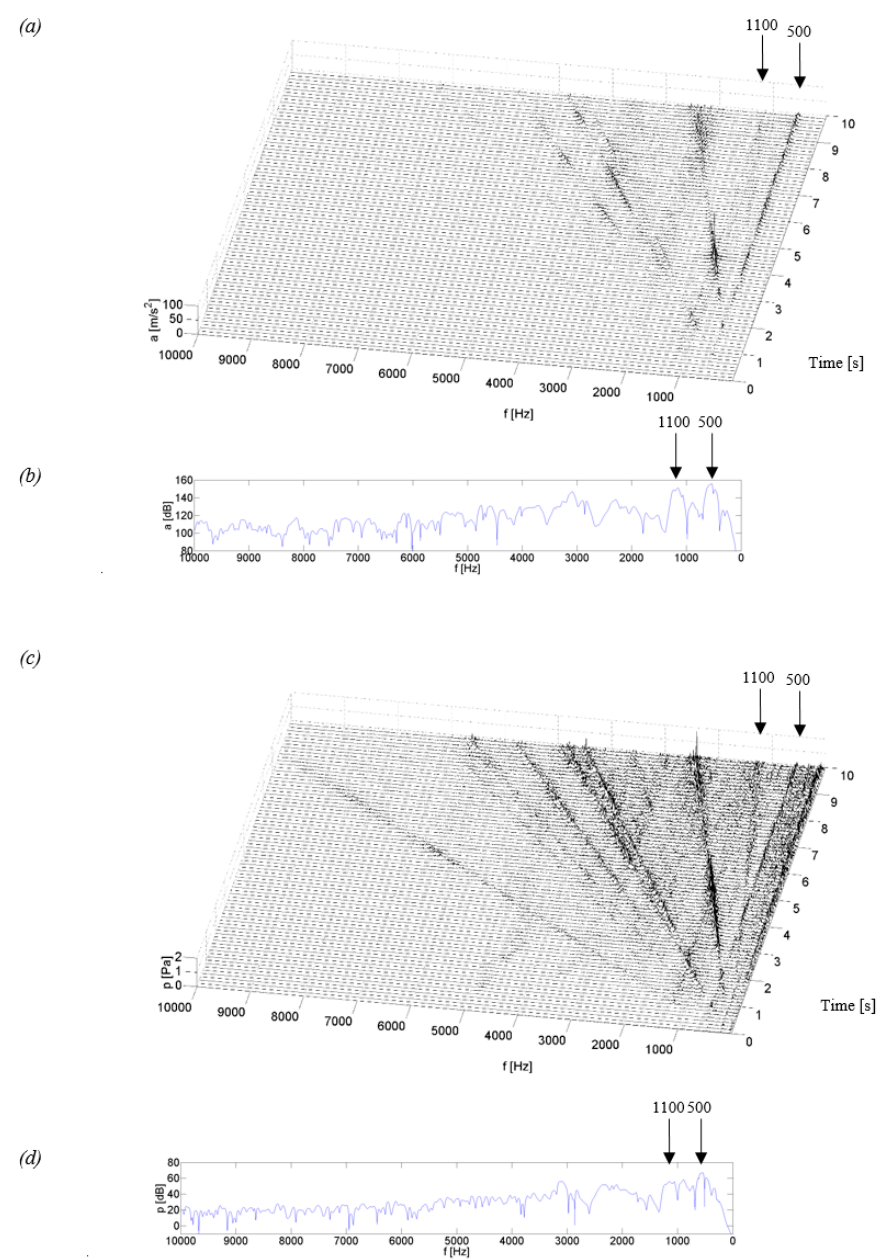
Figure 5. Test results for the K_1 housing: ( a ) time-frequency distributions of vibration acceleration (P_5); ( b ) vibration response (P_5); ( c ) time-frequency distributions of acoustic pressure ( H ); ( d ) acoustic response ( H ).